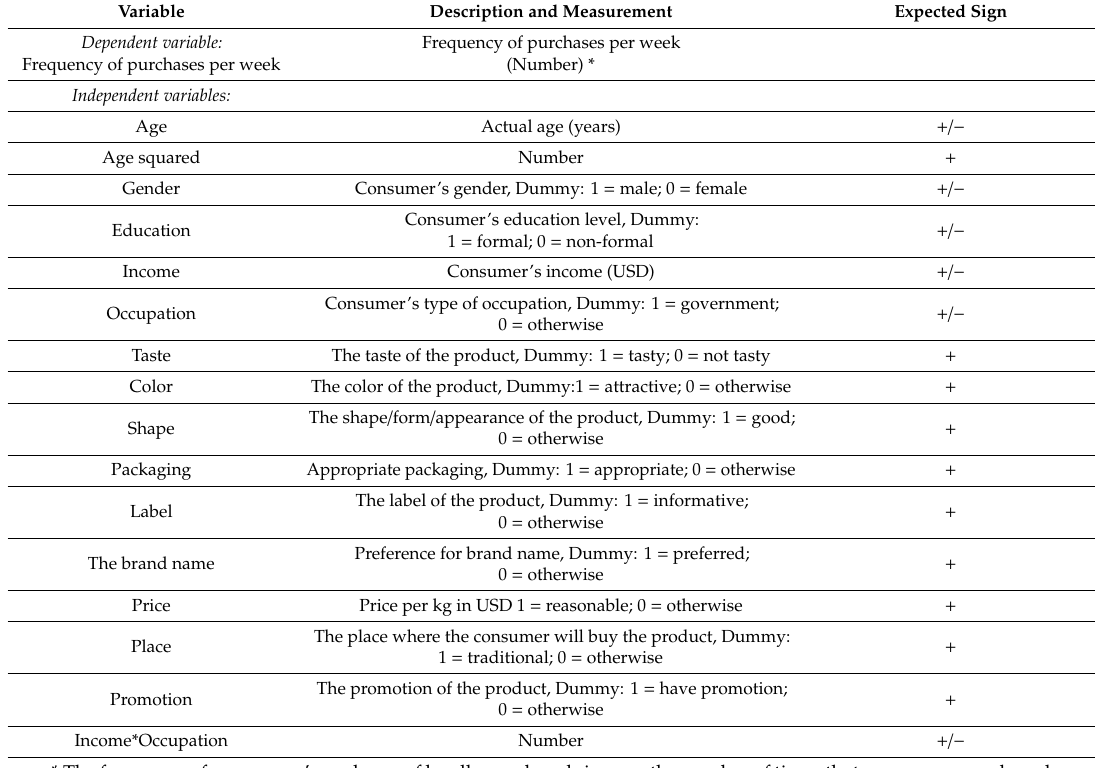
Table 4. Descriptions of variables used for the Poisson regression, as well as their measurements and expected